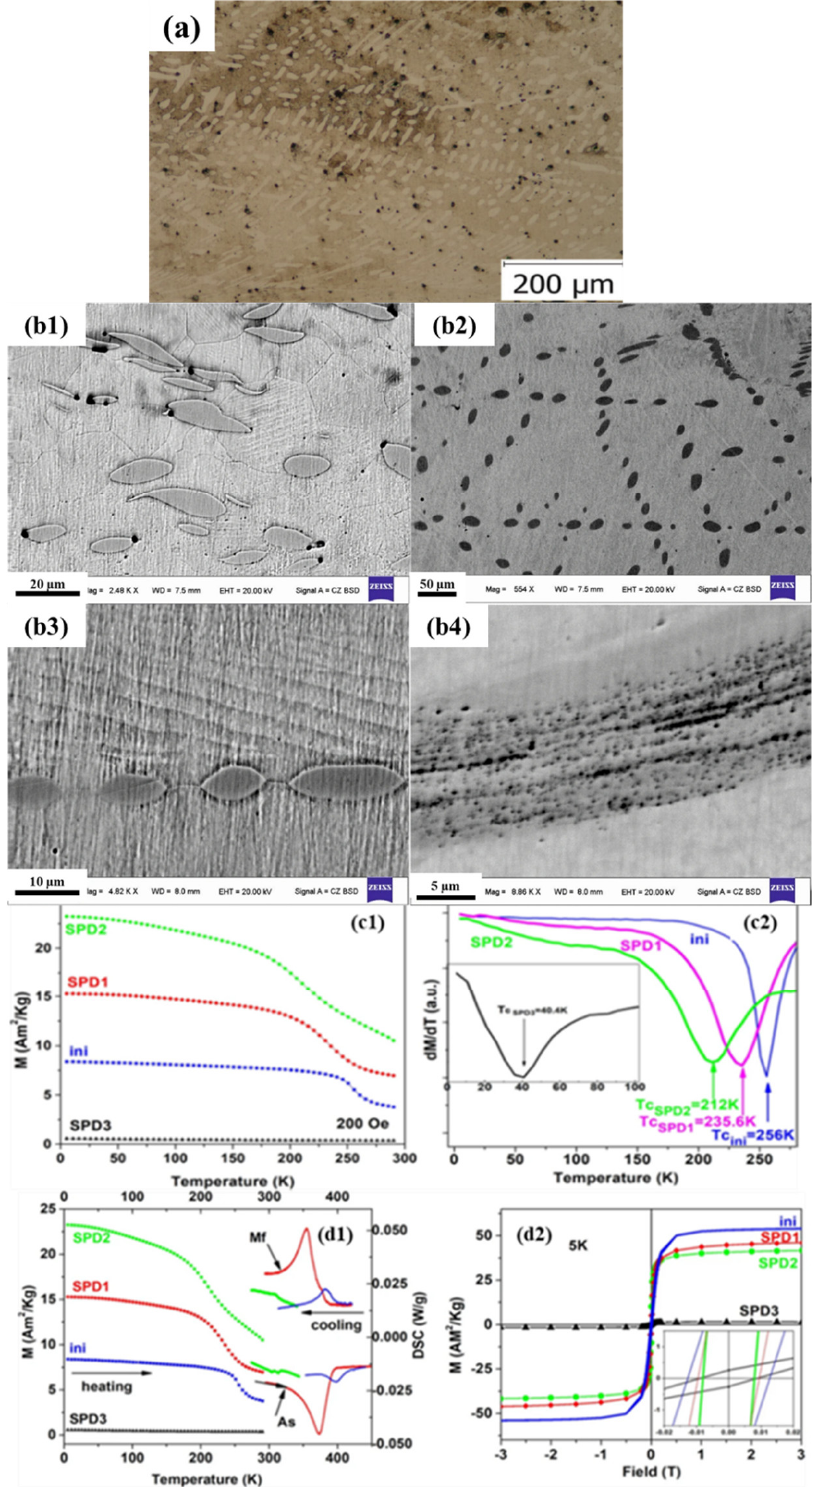
Figure 9. Microstructure evolution ( a ), ( b1 – b4 ), the temperature dependence of magnetization ( c1 , c2 ), magnetization thermal variation ( d1 ), and DSC micrograph ( d2 ) of the Ni 57 Fe 18 Ga 25 disc subjected to the HSHPT process, adapted with permission from [74], 2022, Springer Nature. Note that the Curie temperature (T C ) is evaluated from the first derivative of temperature-dependent magnetization. Also, hysteresis curves are measured at 5 K. The HSHPT samples are categorized into four groups, namely, (ini) for the initial sample, SPD 1 for ε = 0.9, SPD 2 for ε = 1.74, and SPD 3 for ε = 2.82.